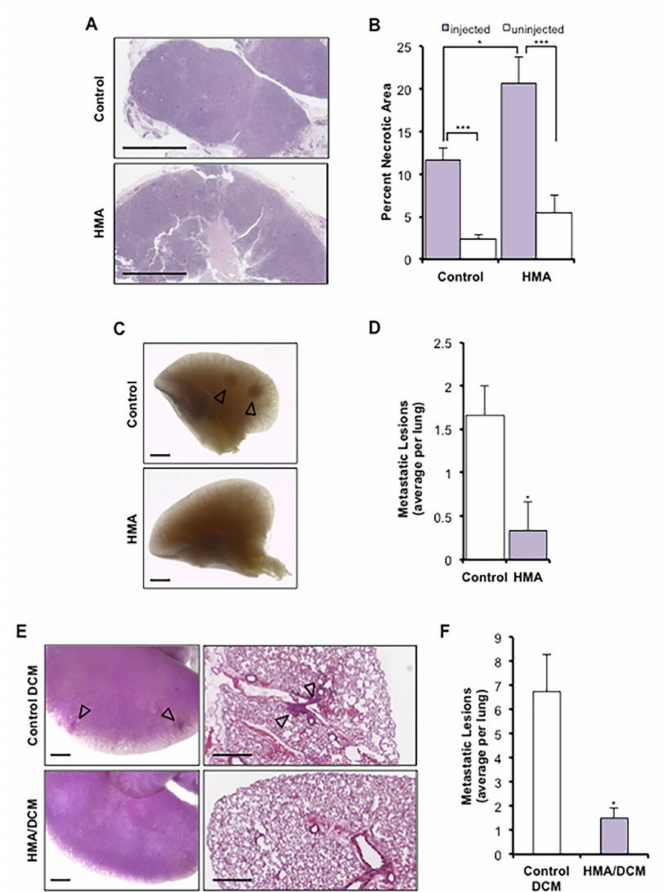
Figure 4. HMA induces necrosis in vivo and suppresses metastasis to the lung. ( A – D ) Met-1 xenograft mammary tumors received daily intratumoral injection of HMA (0.78 µ g/mm 3 tumor volume)